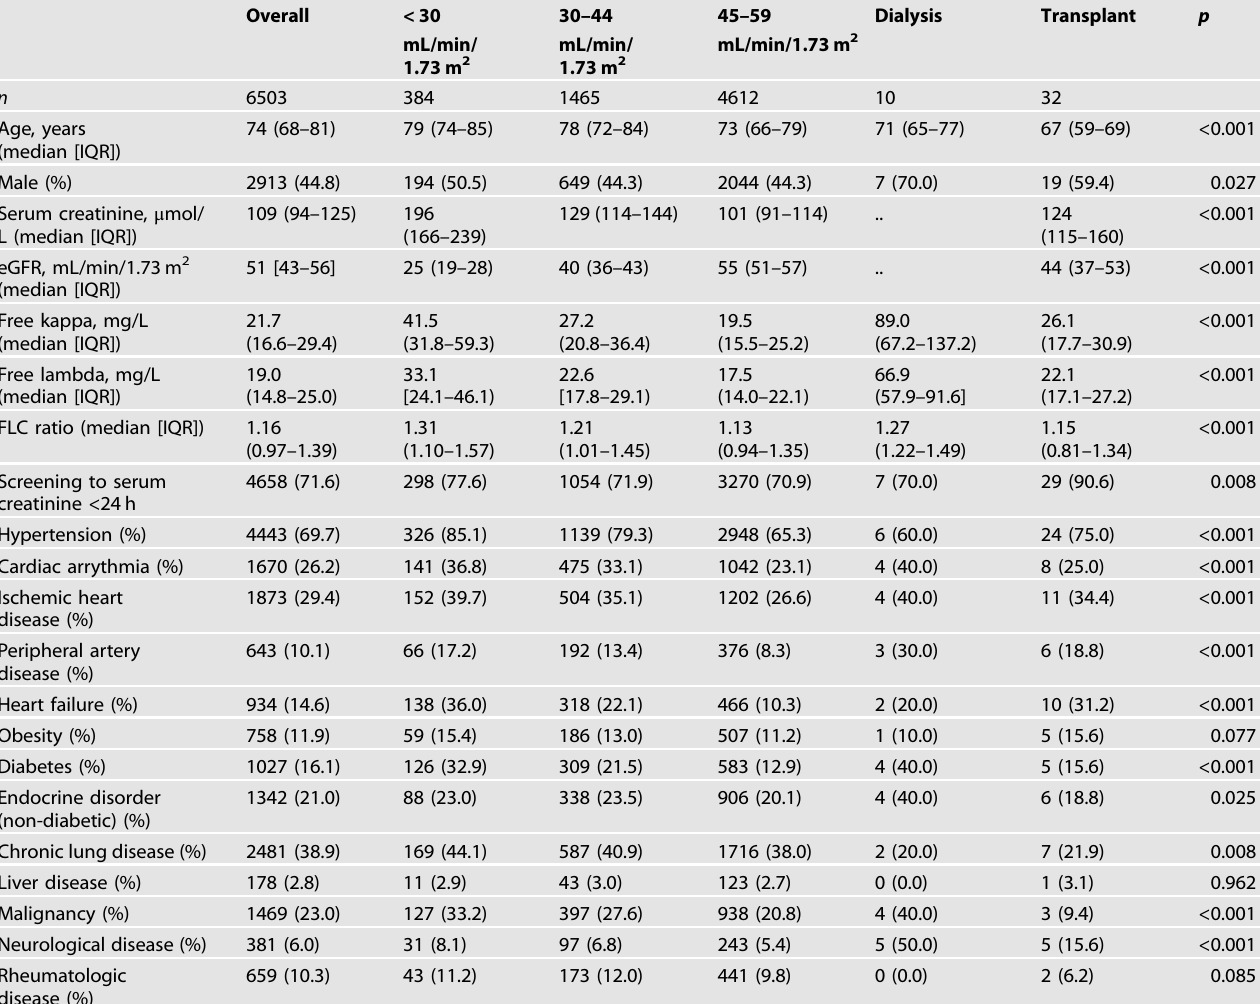
Table 1. Baseline characteristics of iStopMM participants with chronic kidney disease stages 3 – 5, strati fi ed by estimated glomerular fi ltration rate at the time of